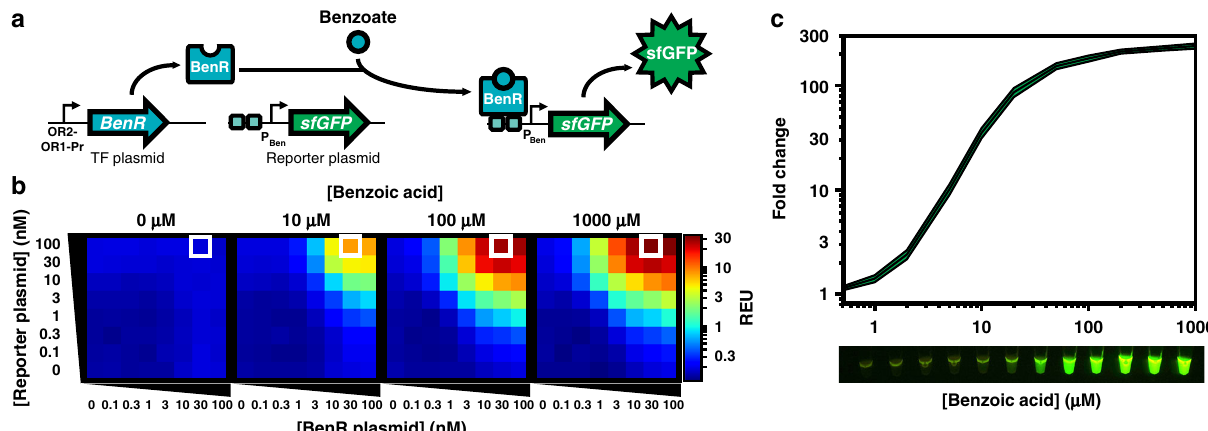
Fig. 2 Calibration of sensor and output modules for benzoate detection. a BenR binds to the P Ben promoter in the presence of benzoate and activates gene expression. Here, BenR is cloned in the pBEAST plasmid (a derivative of pBEST 20 ) and driven by a strong constitutive promoter, OR2-OR1-Pr. The P Ben promoter is cloned into another pBEAST backbone and drives expression of superfolder green fl uorescent protein (sfGFP). As the system operates without a cellular boundary, multiple plasmids encoding different components of the network can easily be used simultaneously. Plasmid concentrations can then be fi ne tuned to identify optimal operating conditions. b Optimization of the BenR sensor and reporter modules. Cell-free reactions of 20 µ l containing different concentrations of the BenR and reporter plasmids were prepared and their response to different concentrations of benzoic acid were monitored. The white square represents the optimal condition (100 nM reporter and 30 nM BenR plasmid) with the highest relative fl uorescence (see Supplementary Fig. 2 and Supplementary Table 1). Reactions were run in sealed 384-well plates in a plate reader at 37 °C for at least 8 h. The heat maps represent the signal intensity after 4 h. Data are the mean of three experiments performed on three different days and all fl uorescence values are expressed in Relative Expression Units (REU) compared with 100 pM of a strong, constitutive sfGFP-producing plasmid. See Methods for more details. c Upper panel: The BenR sensor can detect benzoic acid over three orders of magnitude and at concentrations as low as 1 µ M. Shaded area around curves corresponds to ±SEM of the three experiments. Lower panel: GFP expression in response to the same range of concentrations of benzoic acid as in the upper panel is easily detectable by eye on a UV table. Source Data are available in the Source Data